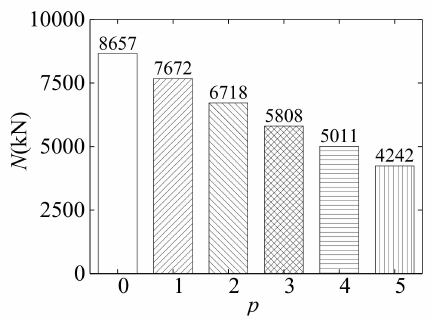
Figure 12. Influence of combined times on the ultimate bearing capacity of the specimen.